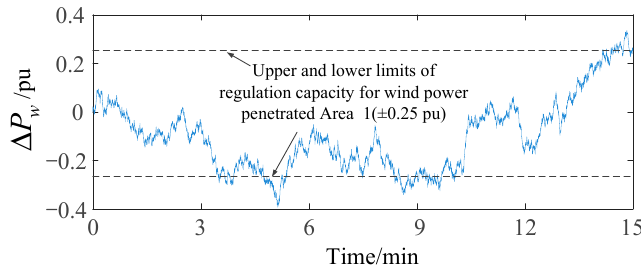
Figure 8. Forecast deviation of wind farm output power.